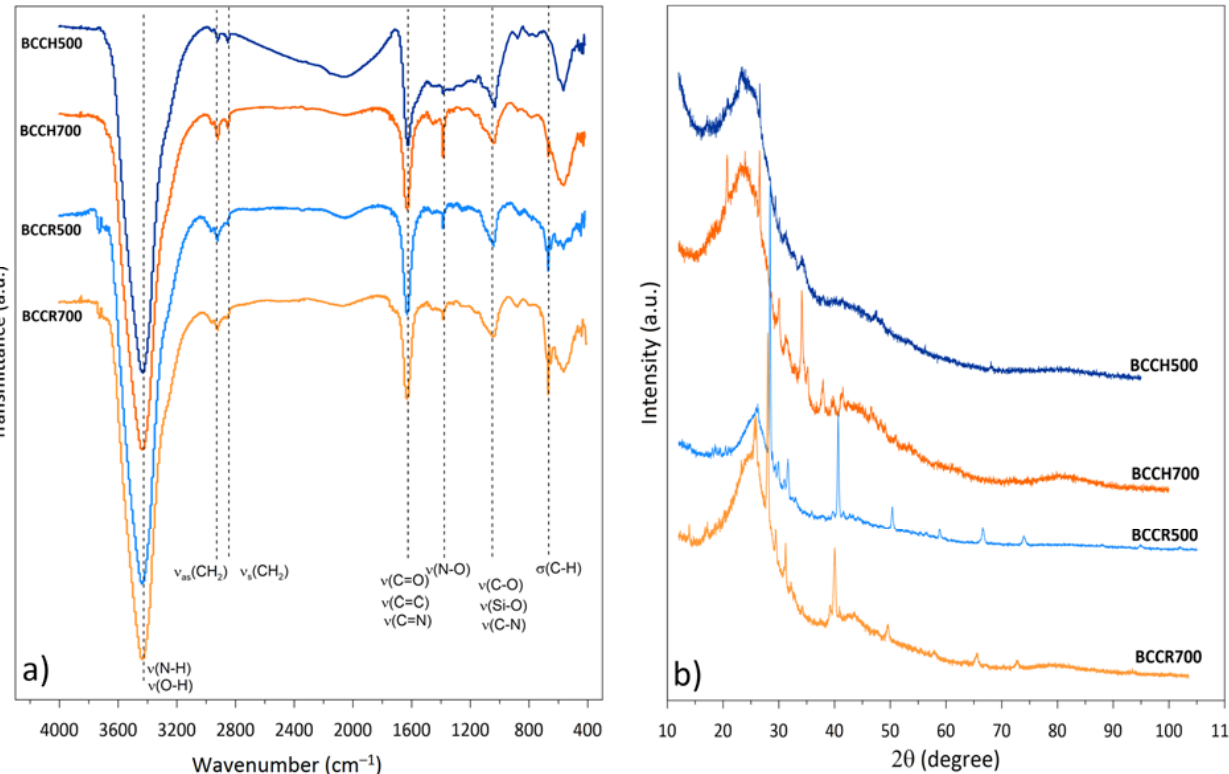
Figure 2. FTIR spectra ( a ) and XRD patterns ( b ) of investigated BC samples.